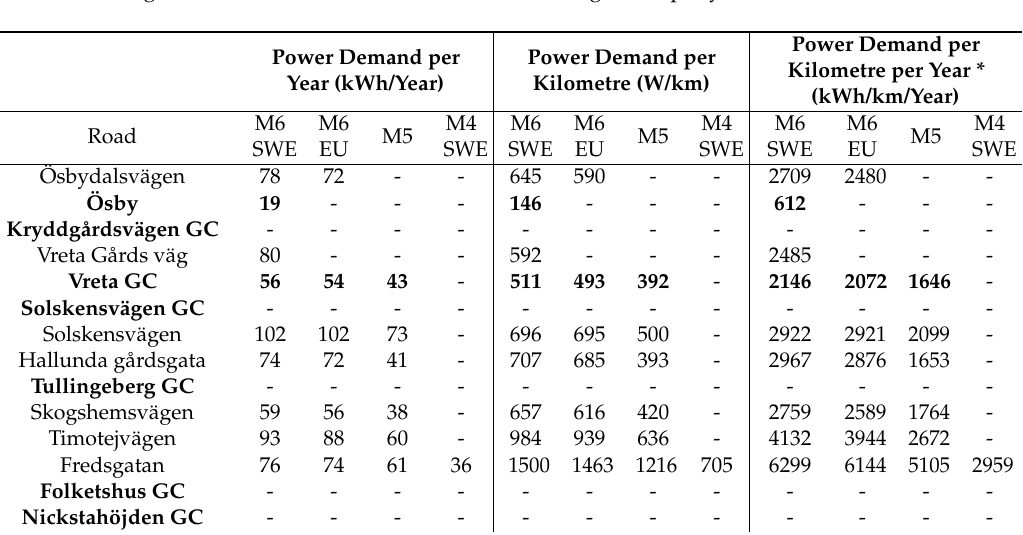
Table 6. Calculated energy savings as power per year (kWh/year), power per kilometre road (W/km) and power per year per kilometre road following adaptation to the minimum requirements of different lighting classes based on percentages shown in Table 4. Mean values based on percentage savings in L , U o and U I ; values not shown when minimum regulations for any of L , U o or U I were violated. SWE = in accordance with Swedish regulations [17], EU = in accordance with European regulations [16]. M5 = in accordance with both Swedish and European regulations. Other M classes are not included, since no savings were found. * = calculated for 4200 burning hours per